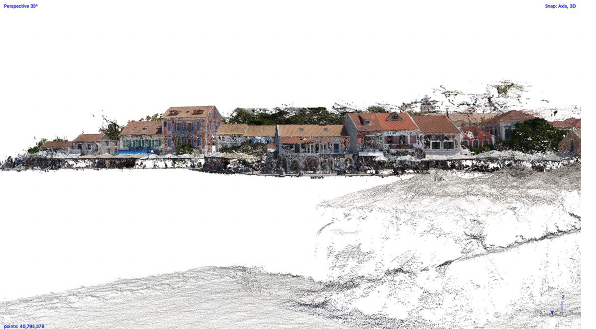
Figure 18 . Fiskardo Port, tessellated model (tiles).